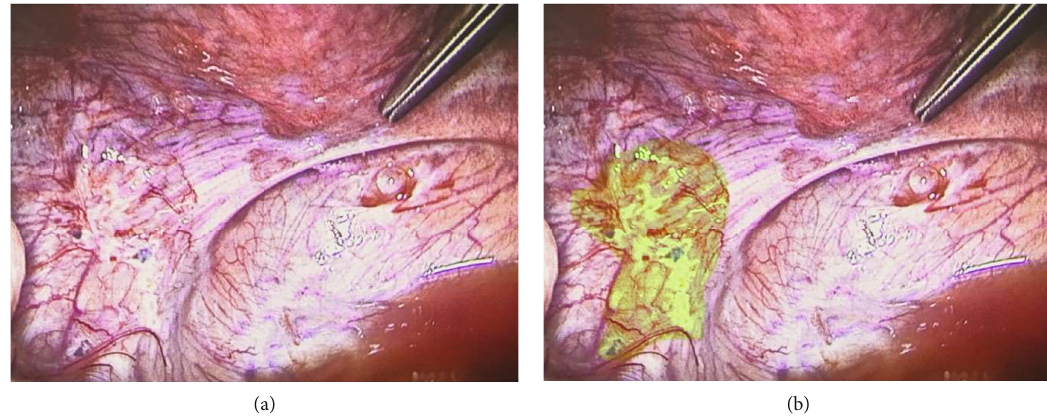
Figure 3: (a) Uterosacral ligament. (b) Same image with “ powder-burn ” lesions in the left ovarian fossa highlighted in light green.